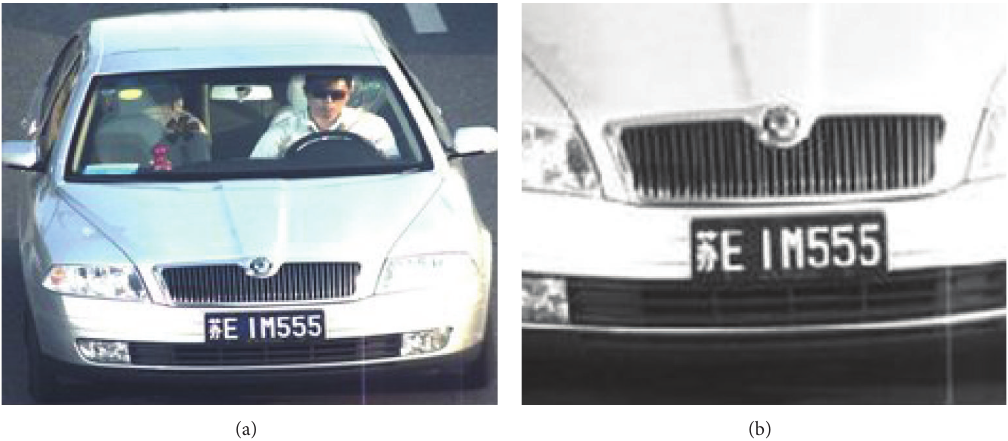
Figure 12: (a) Detected vehicle. (b) Presegmented image.